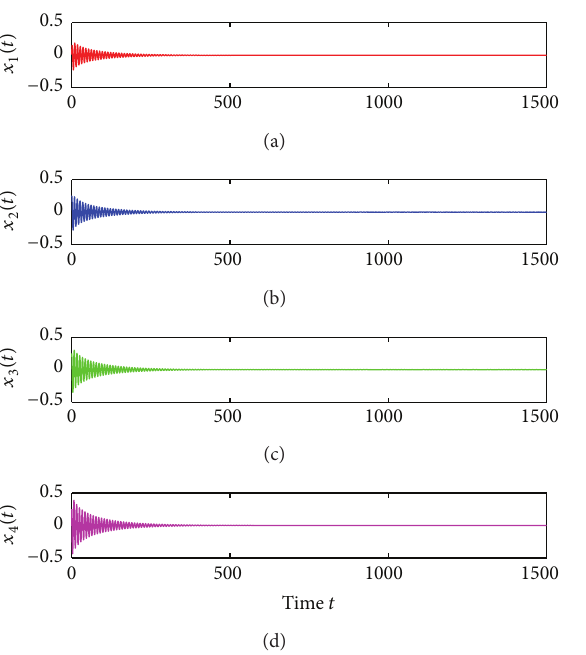
Figure 5: The trajectory of 𝑥 1 , 𝑥 2 , 𝑥 3 , and 𝑥 4 when 𝜏 2 = 2.75 < 3.1610 = 𝜏